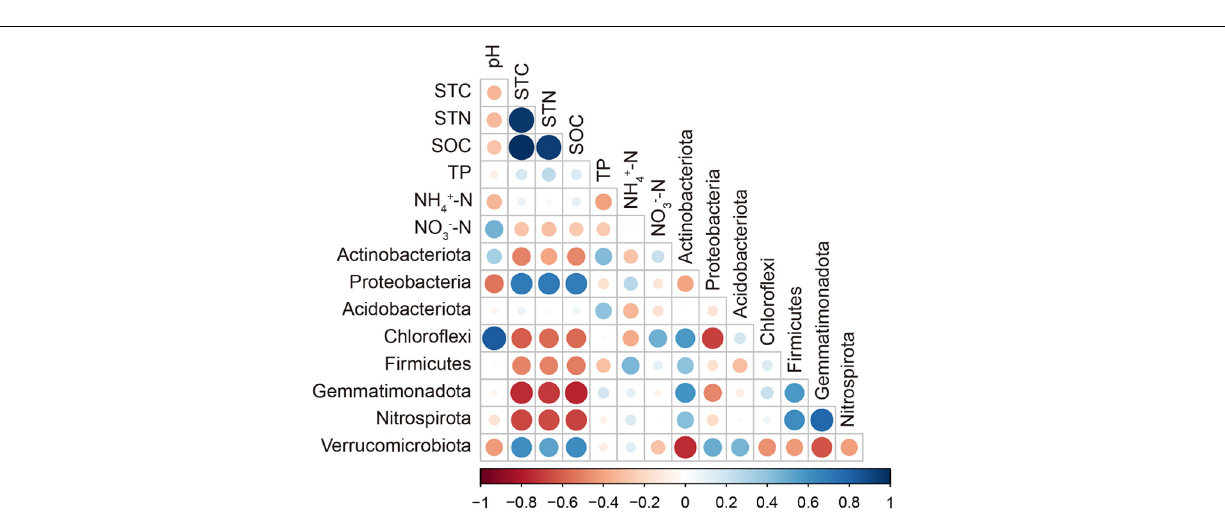
RDA was conducted to investigate the effect of soil chemical properties on the composition of the bacterial community ( Figure 6 ). The adjusted R 2 of the RDA model was 0.498, which means that 49.8% of the total variance of the bacterial community